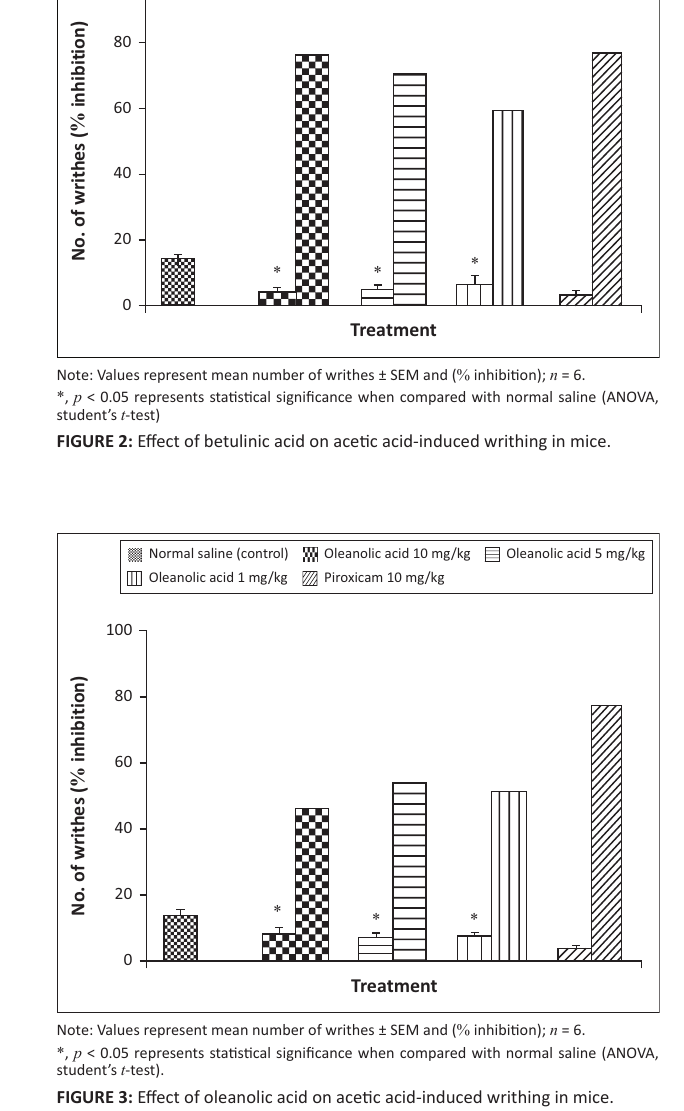
FIGURE 1: Effect of ethyl acetate extract on acetic acid-induced writhing in mice.